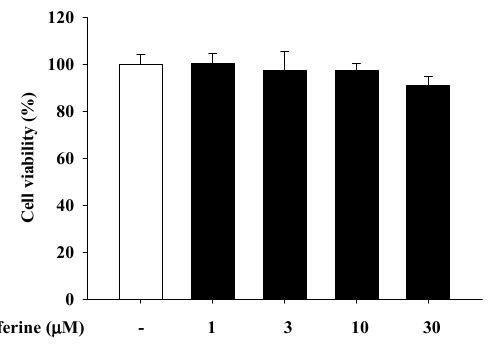
Figure 1. Cell viability in rat mast cells (RBL-2H3) under different concentrations of neferine treatment.